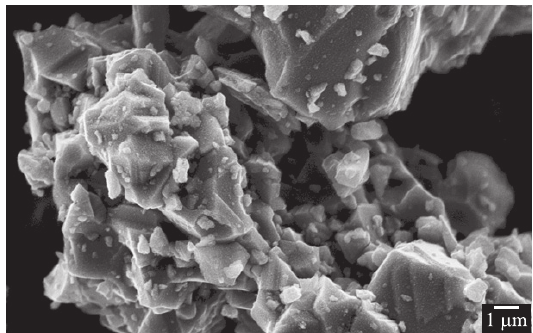
Figure 2. SEM image of the MnZn ferrite used.